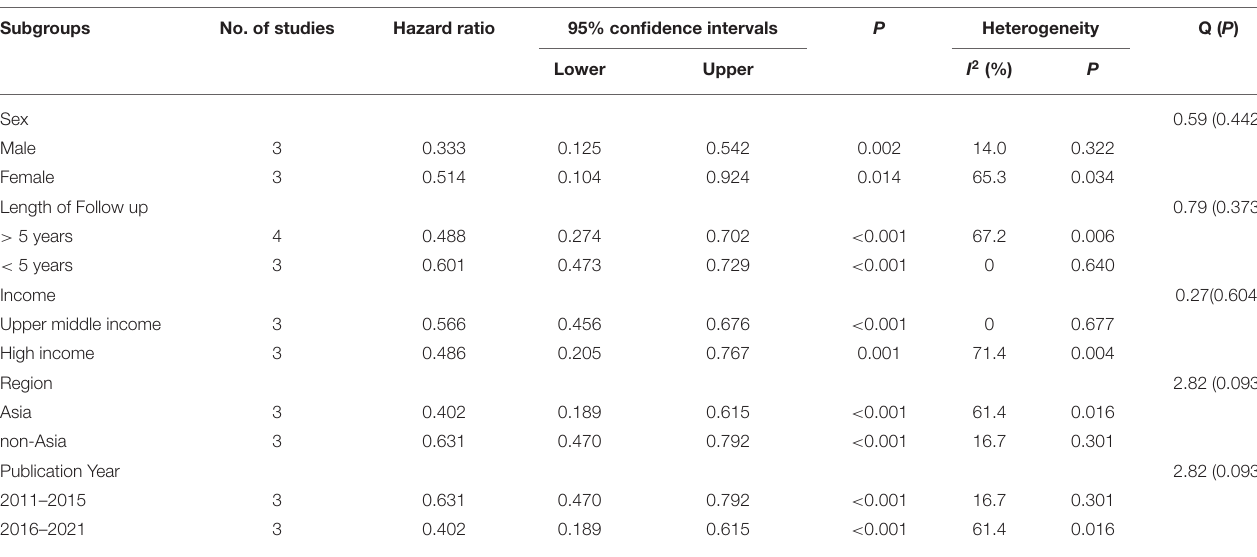
TABLE 3 | Summary estimates on the risk of mortality between